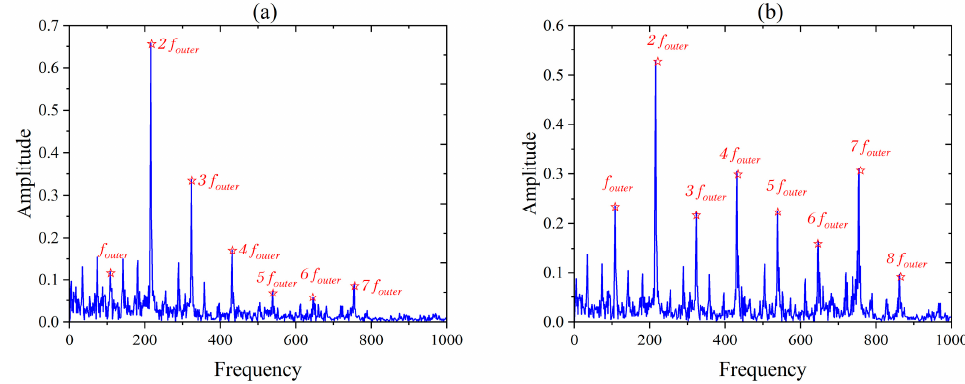
Figure 15. ( a ) The best PF in the RLMD envelope spectrum, and ( b ) The best PF in the CCERLMDAN envelope spectrum. envelope spectrum.